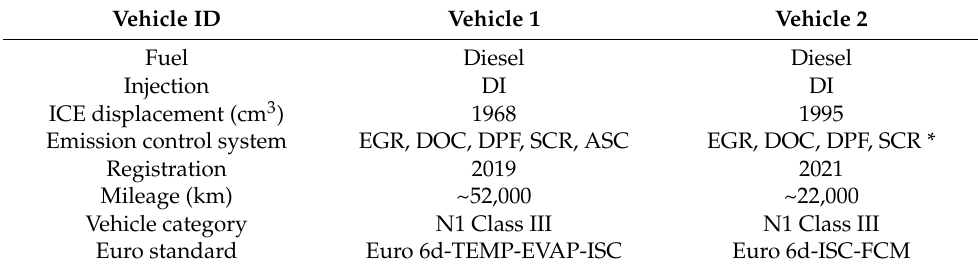
Table 1. Summary of vehicles